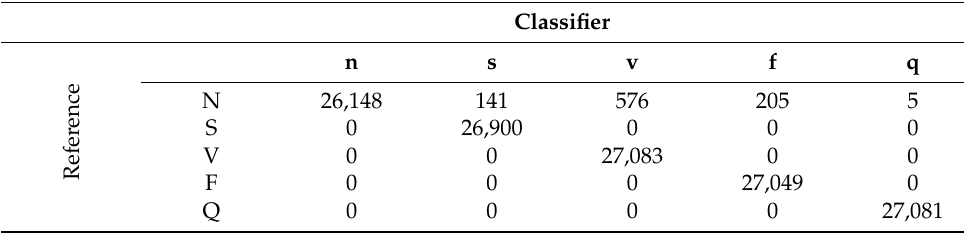
Table 15. Confusion matrix DT-ROS.